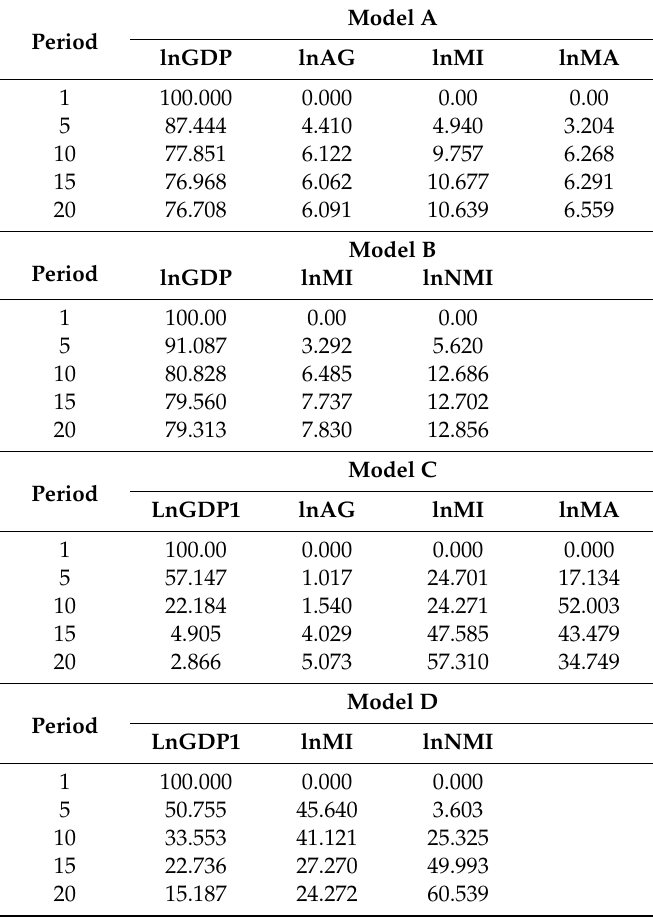
Table 10. Variance